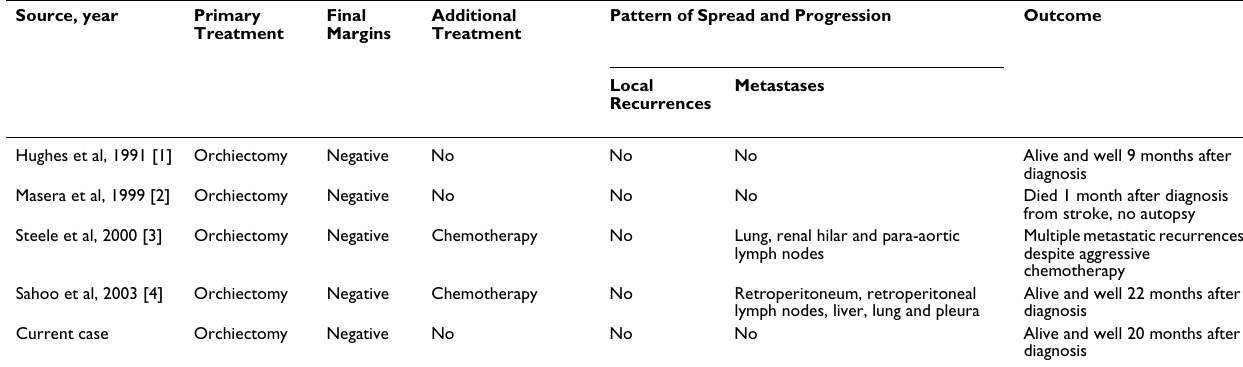
Table 3: Treatment and follow-up for primary testicular angiosarcoma Source,